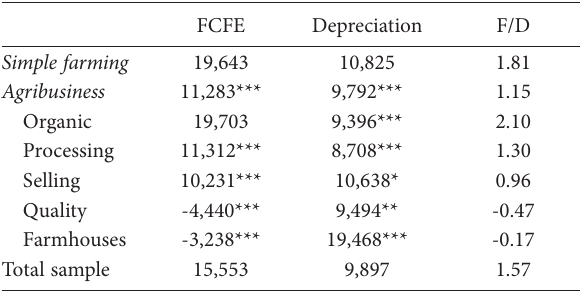
Table 3. FCFE, Depreciation and financial sustainability index over the entire three-year constant